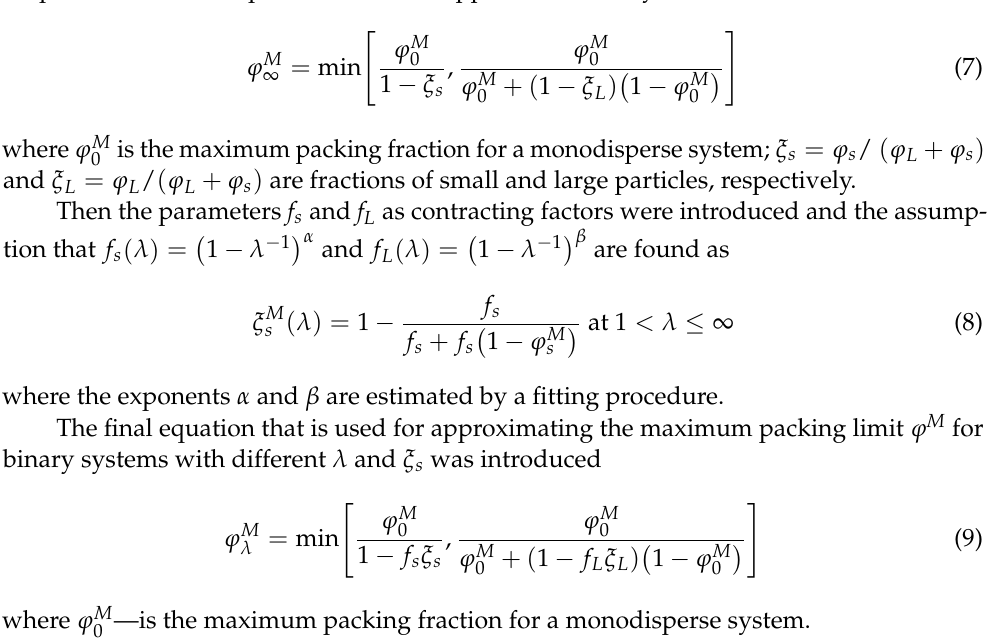
Figure 8. Dependence of the shear elastic modulus on the shear stress in 75 vol. % ( a ) and 80 vol. % ( b ) suspensions ( λ = 2.4) with different content of larger and smaller particle ratios.